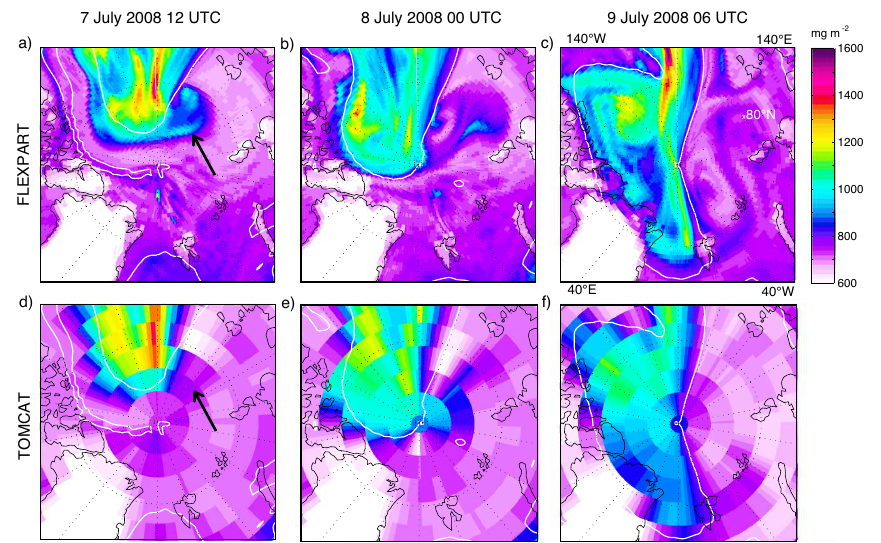
Fig. 6. Zoomed view of total column CO (shading, mgm − 2 ). (a – c) Total column CO from the FLEXPART simulation on 7 July 2008 12:00UTC, 8 July 2008 00:00UTC and 9 July 2008 06:00UTC. (d – f) Total column CO from the TOMCAT simulation for the same period. White contour shows the dynamical tropopause at 320K (2pvu). Data are shown on the output grid without spatial